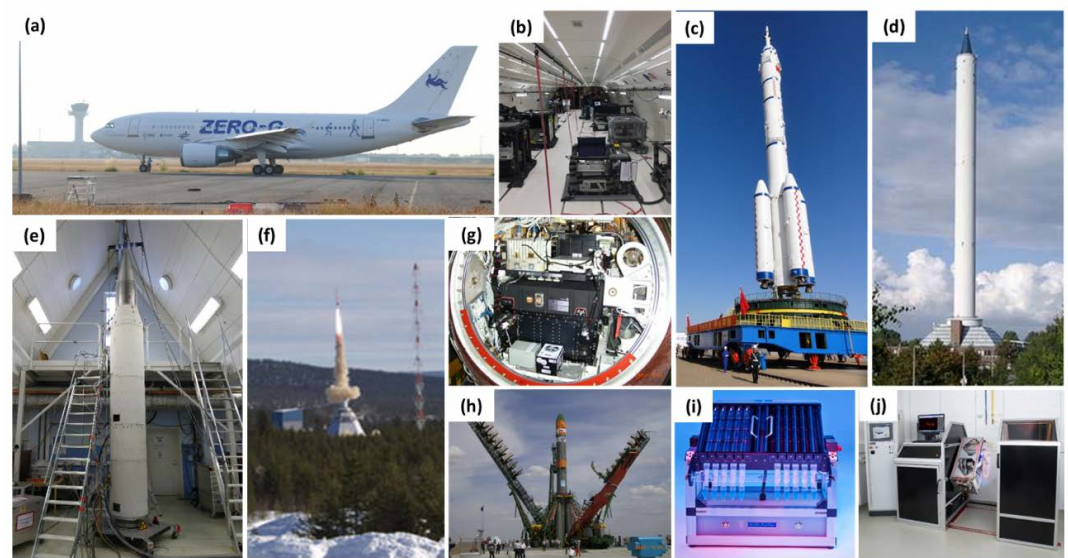
Figure 1. Images of platforms for conducting experiments in real and simulated microgravity conditions. ( a ) Parabolic aircraft (Airbus A310 ZERO G) operated by Novespace, Bordeaux, France. About 22 s of microgravity can be achieved during a parabolic flight manoeuvre. ( b ) Experimental area inside the ZERO G aircraft with di ff erent experiment racks. ( c ) The Chinese Long March 2F (Shenzhou 8 mission launched in 2011 from the Jiuquan Satellite Launch Center, China). ( d ) The ZARM drop tower in Bremen, Germany. With a drop tower, approximately 4.5 s of microgravity can be achieved. ( e ) Payload of a MAXUS-sounding rocket (Kiruna, Sweden). A huge castor engine provides su ffi cient impulse to achieve microgravity up to 14 min. ( f ) Sounding rocket, TEXUS in Kiruna, Sweden, which enables microgravity for about 5–7 min. ( g ) Experiment capsule of the Foton-M No. 2 spacecraft with various experimental containers. ( h ) The Russian Soyuz-U rocket (Foton M No.2-mission, launched in 2005 from the Baikonur Cosmodrome, Kazakhstan). ( i ) Two-dimensional pipette Clinostat (Invented and developed by Jens Hauslage from the DLR. Samples in pipettes are rotated with a speed, which compensates the sedimentation of objects inside the pipettes. Sample fixation is achieved by tilting the rotation platform, so that the samples were simultaneously transferred into flasks with fixation reagent (the falcon tubes on the picture). ( j ) Two-dimensional Clinostat with attached microscope (Fluoreszenz Klinostaten Mikroskop; invented and constructed by Jens Hauslage (DLR) and Kai Waßer (DLR)). The microscope enables bright field as well as fluorescence microscopy. Both the instruments (i, j) are located in the microgravity lab of the DLR in Cologne and are available for external